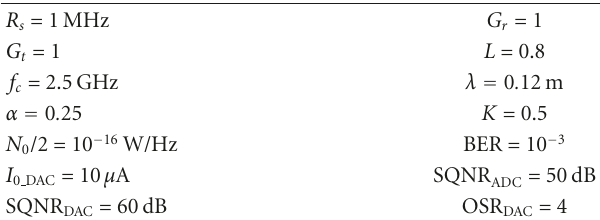
Table 1: System parameter values for Wi-Fi application considered in determining the optimal modulation level b